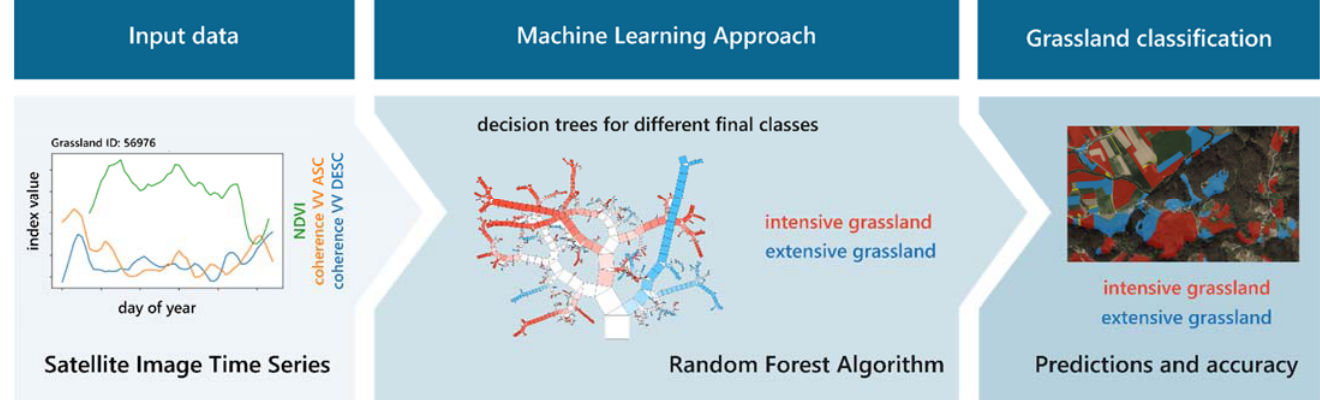
Figure 1. Methodological framework for time series object ‐ based classification adopted in this study.